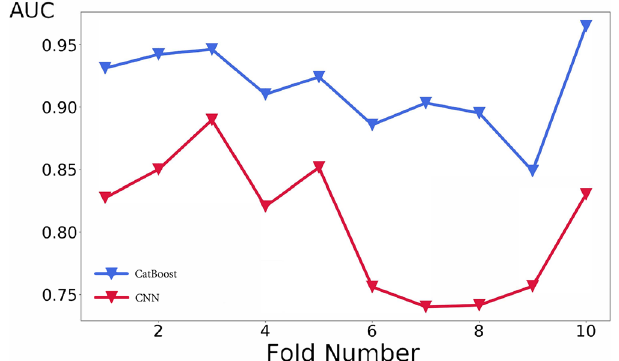
Figure 7. Cross validation of the CatBoost and CNN classifiers. A roughly common trend can be discerned, however the highest score is reached at different folds (3rd for the CNN and 10th for the CatBoost